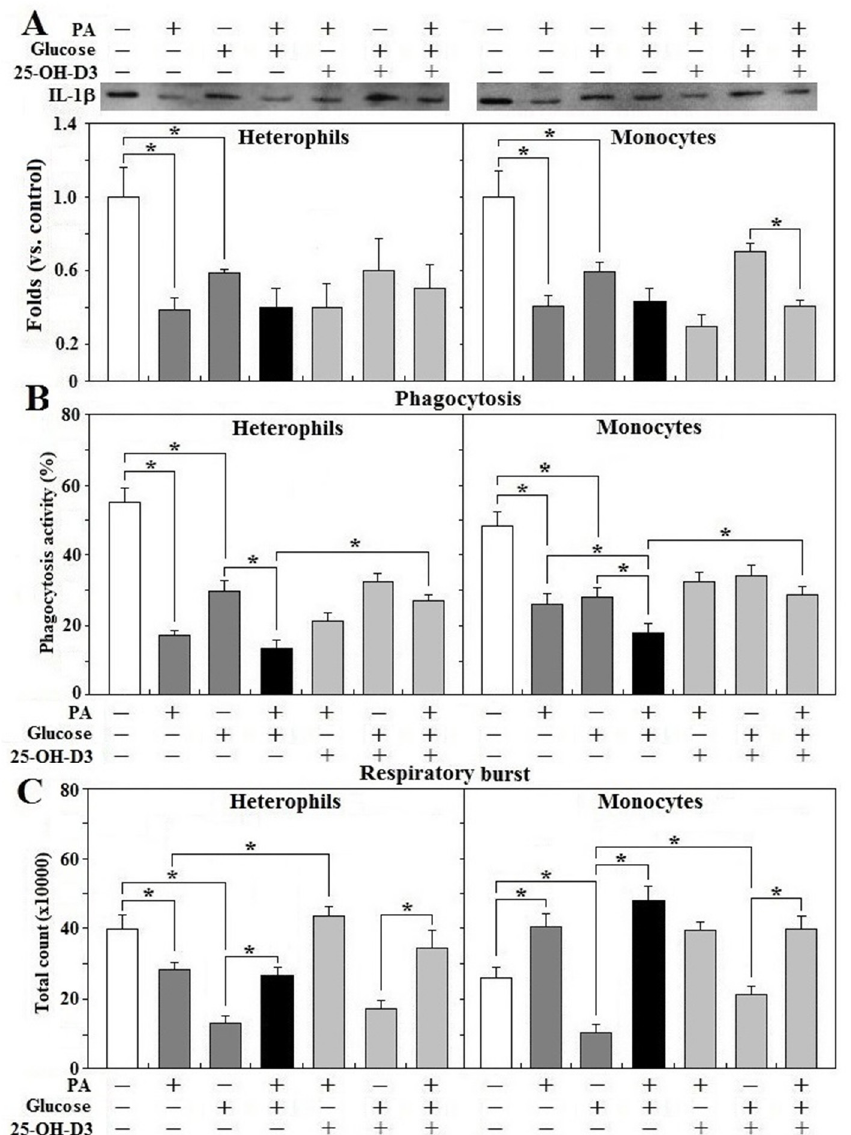
Figure 7. Effects of 25-OH-D 3 on leukocyte functions challenged with glucose and/or palmitic acid. Peripheral heterophils and monocytes (2 × 10 6 cells) isolated from R-hens at age 61–65 weeks were treated with vehicle, 25-hydroxycholecalciferol (25-OH-D 3 , 50 nM), palmitic acid (PA, 1.5 mM), and/or glucose (200 mg/dL) overnight (16 h). Media were collected for interleukin-1 β (IL-1 β ) analysis ( A ) based on the equivalent amounts of protein and cells used for phagocytosis ( B ) and respiratory burst analysis ( C ) ( n = 4). Chemiluminescence results of respiratory burst analysis were expressed as integrated counts over 45 min. Results of Western blots were expressed as rations relative to control (no PA, glucose and 25-OH-D 3 supplementation). *, significant difference vs. corresponding control ( p < 0.05). + or − indicates with or without PA, glucose, or 25-OH-D 3